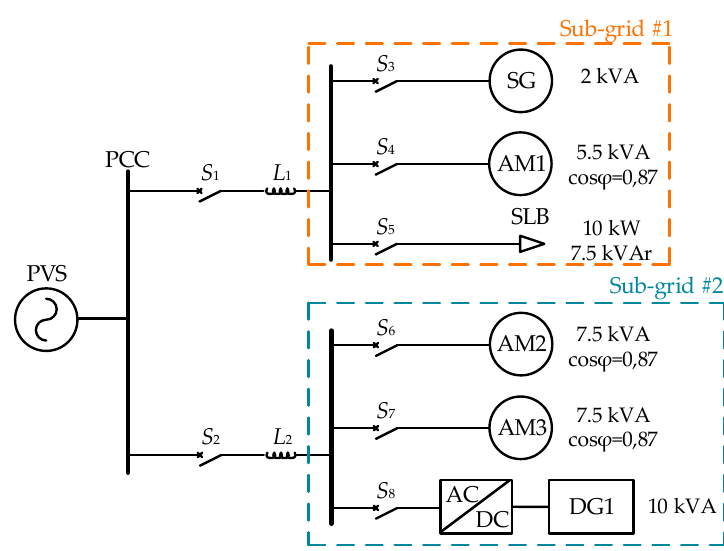
Figure 10. Laboratory-scale active distribution network (ADN).